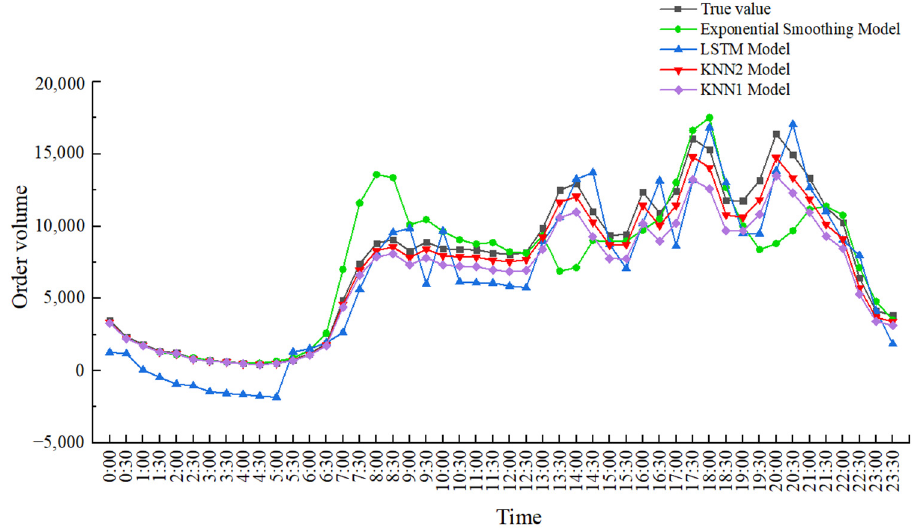
Figure 6. Comparison of the predicted values of online car-hailing demand by different models.